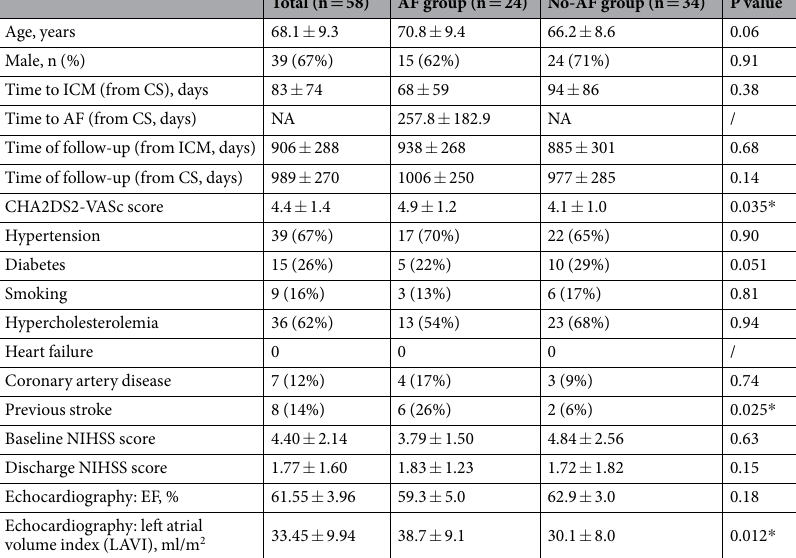
Table 1. Demographic data, CHAD 2 VASC 2 score, risk factors, stroke severity, echocardiography measures and temporal monitoring for AF in all patients and in AF and no-AF group. Data are shown as means ± standard deviation for continuous variables or numbers (percentage) for categorical variables. AF, atrial fibrillation; ICM, insertable cardiac monitor; CS, cryptogenic stroke; NA not applicable; EF, ejection fraction. * p < 0.05.